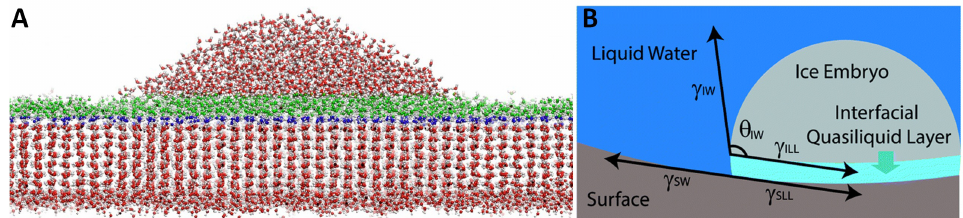
Figure 17. ( A ) Pre-melting quasi-liquid layer (QLL) at the ice-water interface; ( B ) Heterogeneous nucleation in a nanopit that shows ice embryo and interfacial quasi-liquid layer (QLL). Reprinted with permission from Refs. [131,169], respectively. c (cid:13) 2014 Elsevier; c (cid:13) 2014 Royal Society of Chemistry.